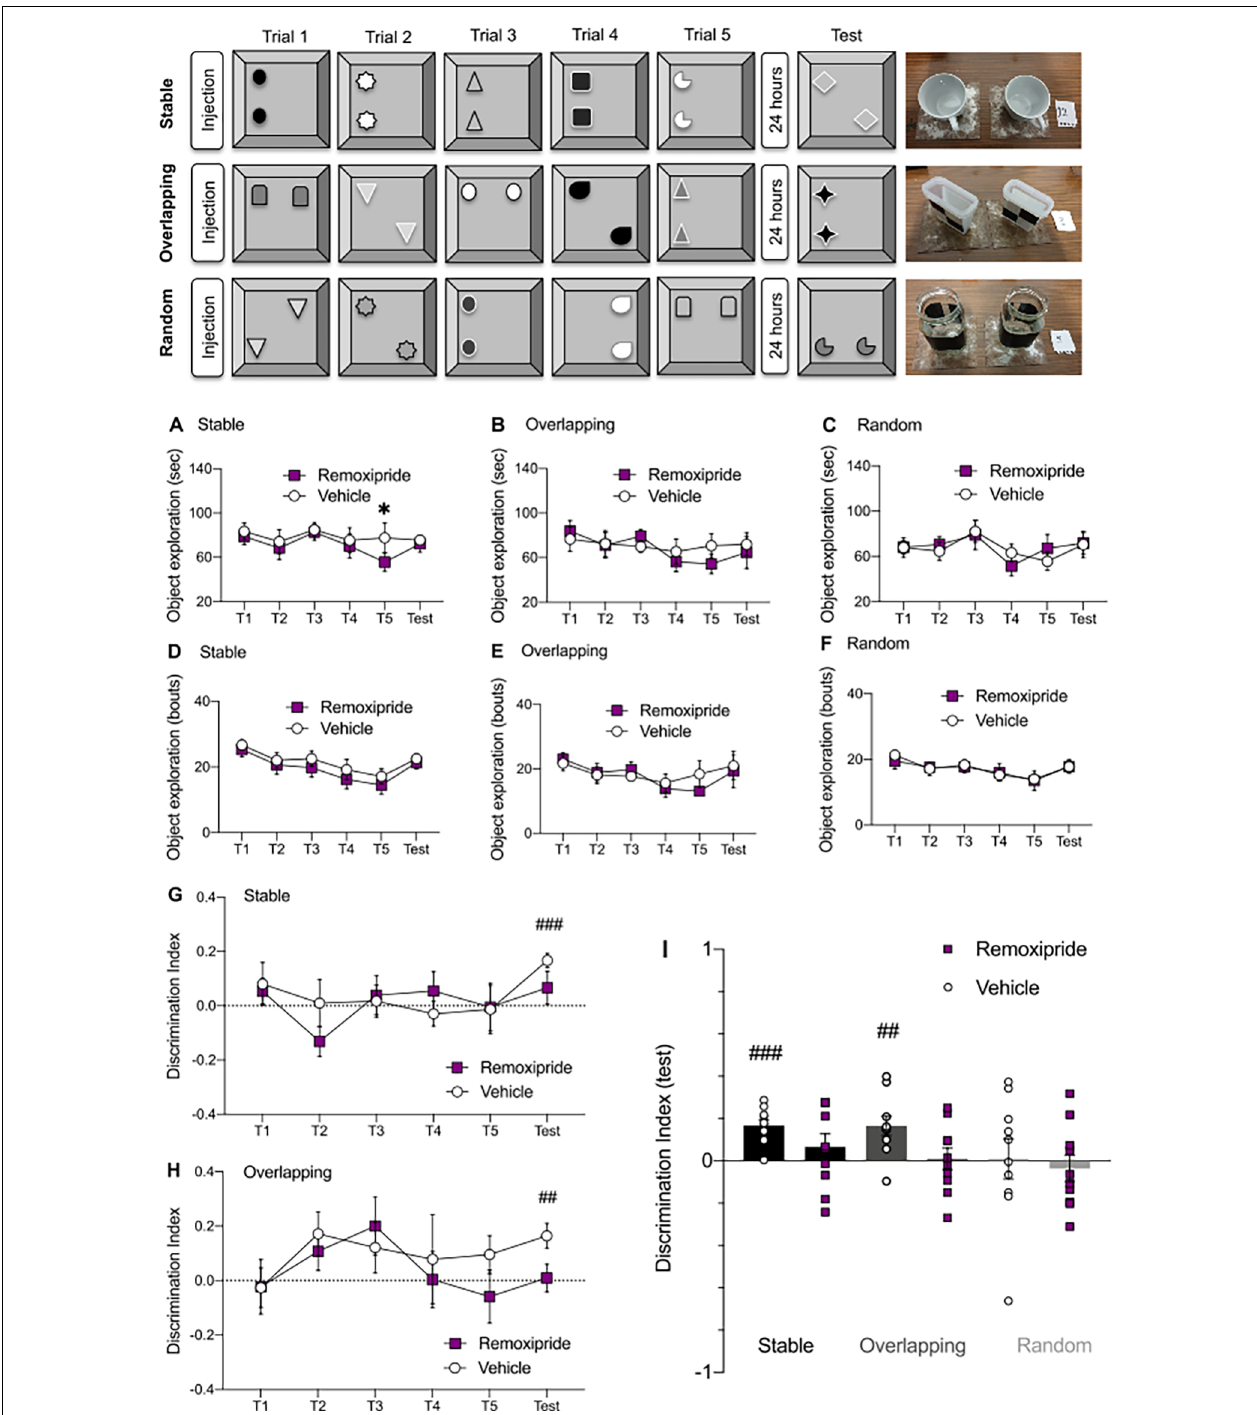
FIGURE 4 | Dopamine D2-like receptor (D2R) antagonism alters the capacity to form cumulative memories. (Top panel) Schematic representation of the Object-Space Task. In all conditions the object identity changed during each trial and in the test session. The right side of the schema shows examples of some of the objects used. In the stable condition, the object position remained constant between trials 1–5. Twenty-four hours later, in the test phase, one of the objects was displaced from the familiar location. In the overlapping condition, one object remained in a constant position and one object was displaced in Trials 1–5. During the test phase, object identity was changed, but the objects occupied the positions occupied in Trial 5. In the random condition object locations varied randomly during all trials and in the test session. (A) The total object exploration time (sec) was lower for the last training trial under remoxipride treatment for the stable condition